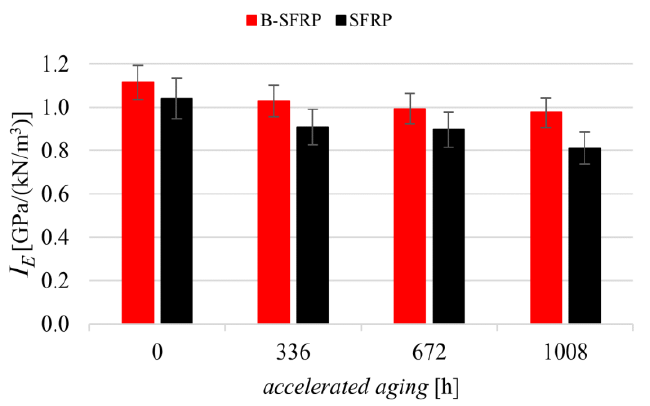
Figure 11. Specific stiffness of the SFRP and B-SFRP before and after the progressive aging.